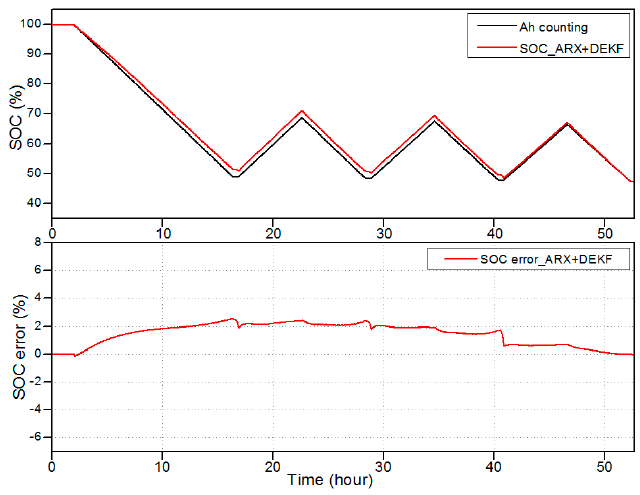
Figure 14. SOC estimation of the variable temperature profile by the proposed method.